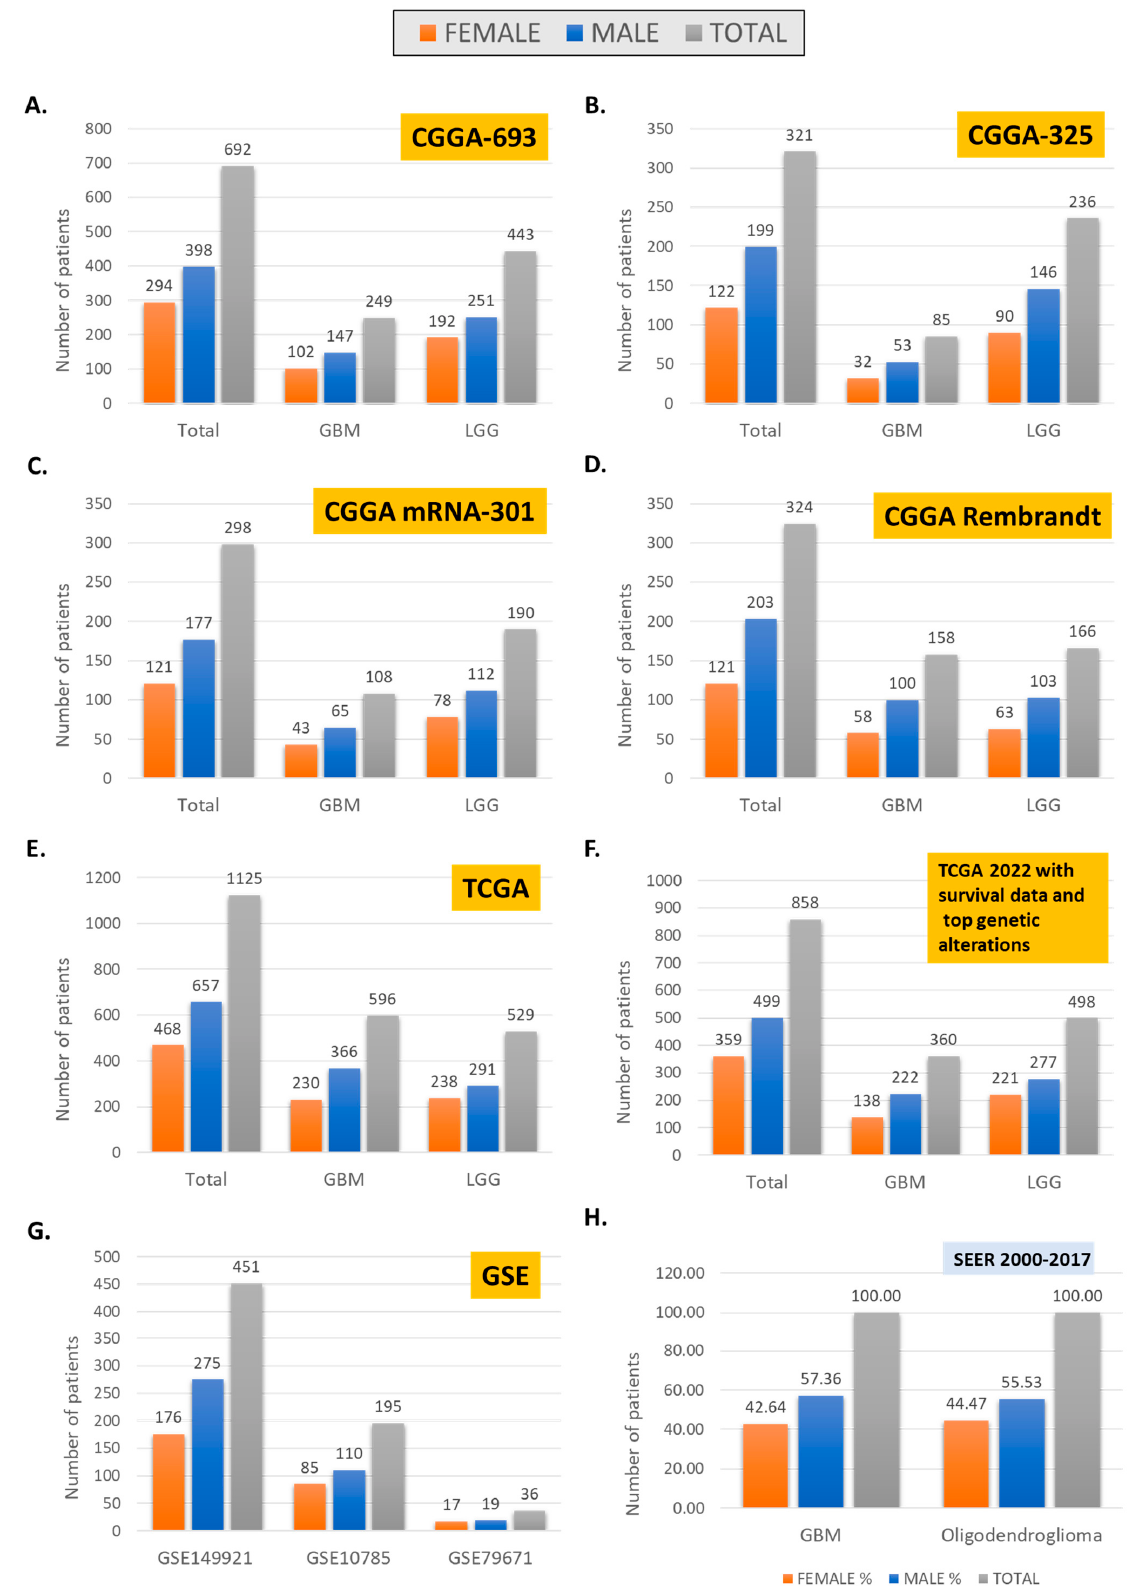
Figure 2. Gender distribution in large-scale omic data sets, CGGA ( A – D ), TCGA ( E , F ), GSE ( G ), and SEER ( H